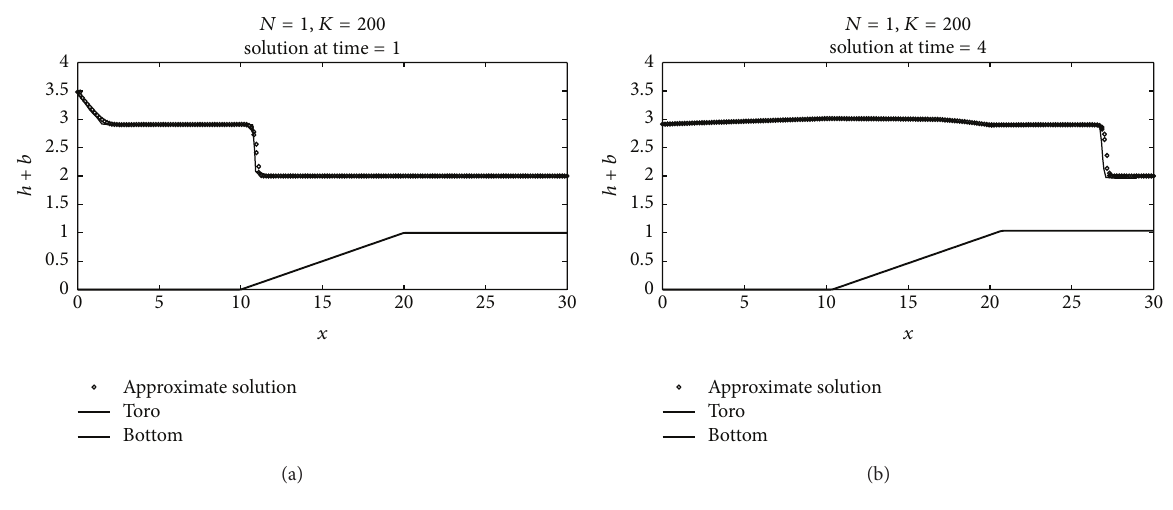
Figure 9: Flow over non-horizontal bed at time 1s (a) and 4s